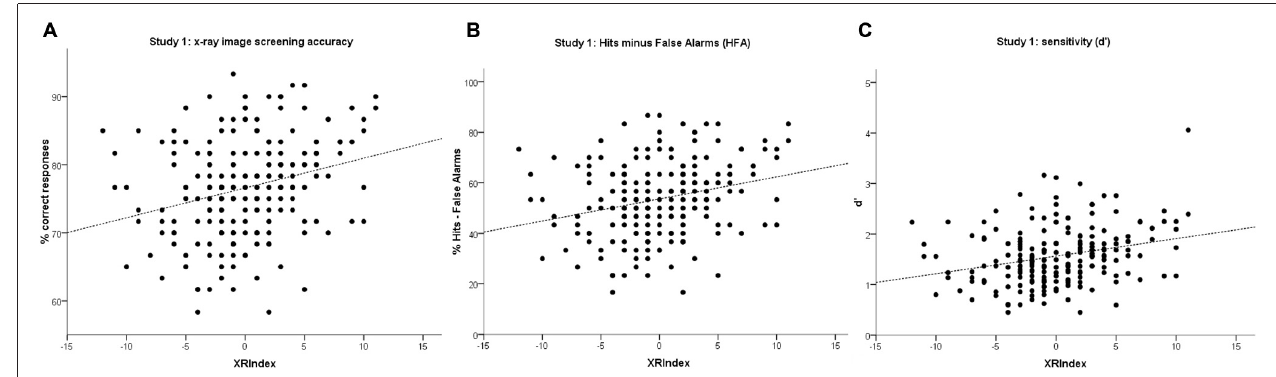
FIGURE 4 | Scatterplots with linear regression models for the XRIndex on: (A) overall accuracy; (B) Hits minus False Alarms (HFA); and (C) sensitivity (d’) in Study 1. Each point may represent one or more participants.